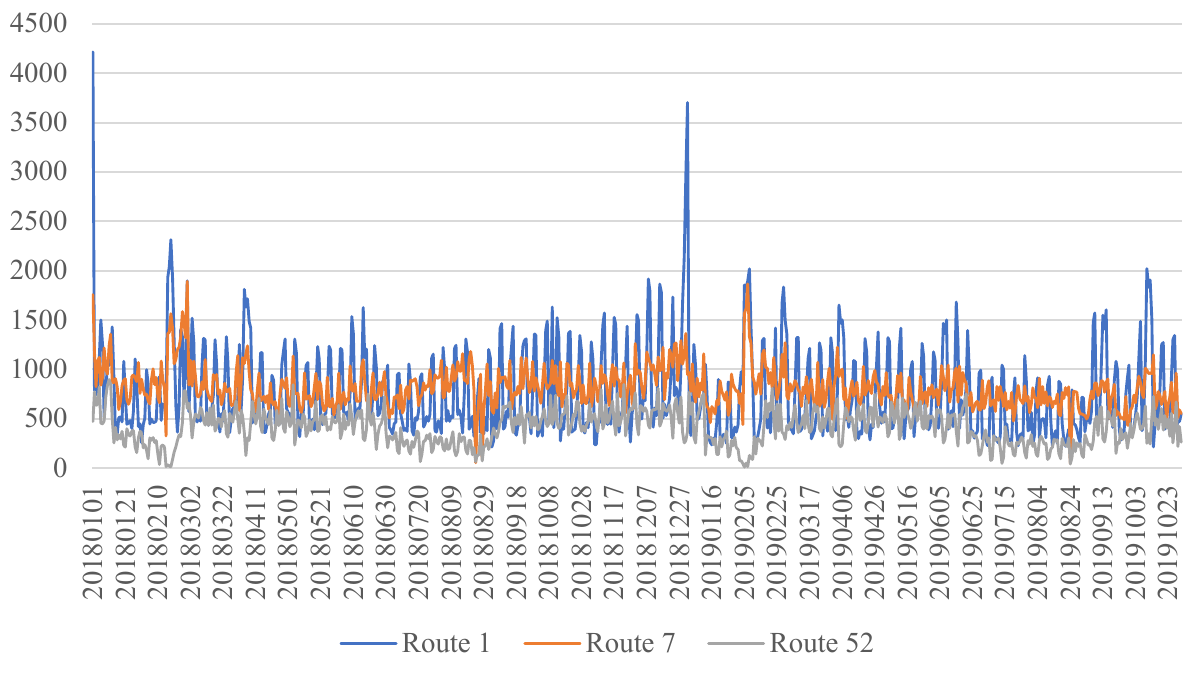
Figure 3. The number of passengers per day for the top three routes by week.